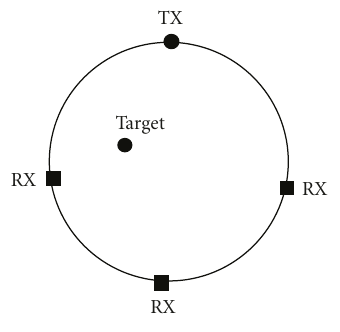
Figure 1: Anti-intruder